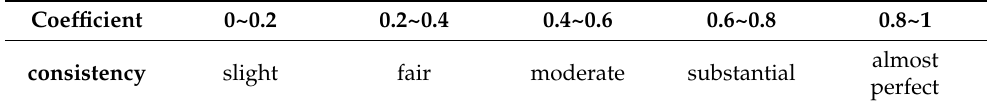
Table 7. Comparison of fusion